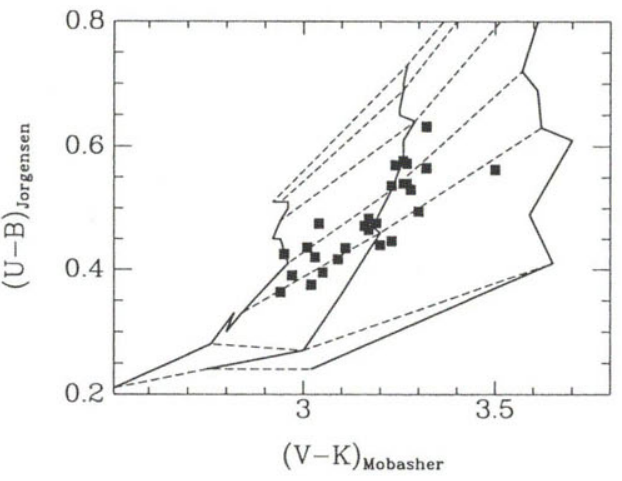
Fig. 16. Optical-infrared color-color relation for the Coma cluster. The data are from J0rgensen (2000) and Mobasher et al. (1999). The lines represent stellar population models by Vazdekis et al. (1996). Solid lines - metallicities of [Fe/H] = - 0.4, 0.0 and 0.4; the lowest metallicity leads to the smallest V-K. Dashed lines - ages of 1, 2, 5, 8, 12, 15 and 17 Gyr; the largest ages lead to the largest